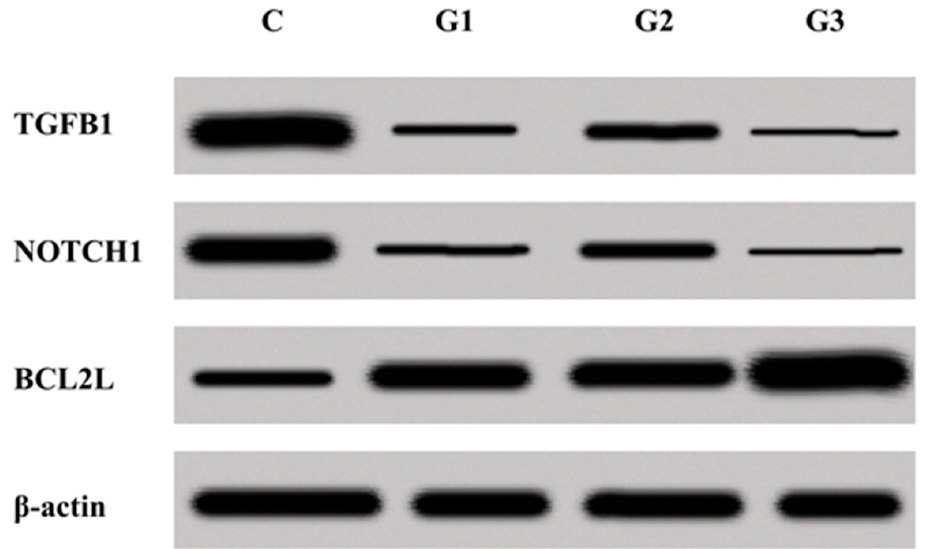
Figure 4. Expression of TGF β 1, NOTCH1, and BCL2L in endometrial cancer tissue (G1–G3) and a control obtained via the Western blot technique.